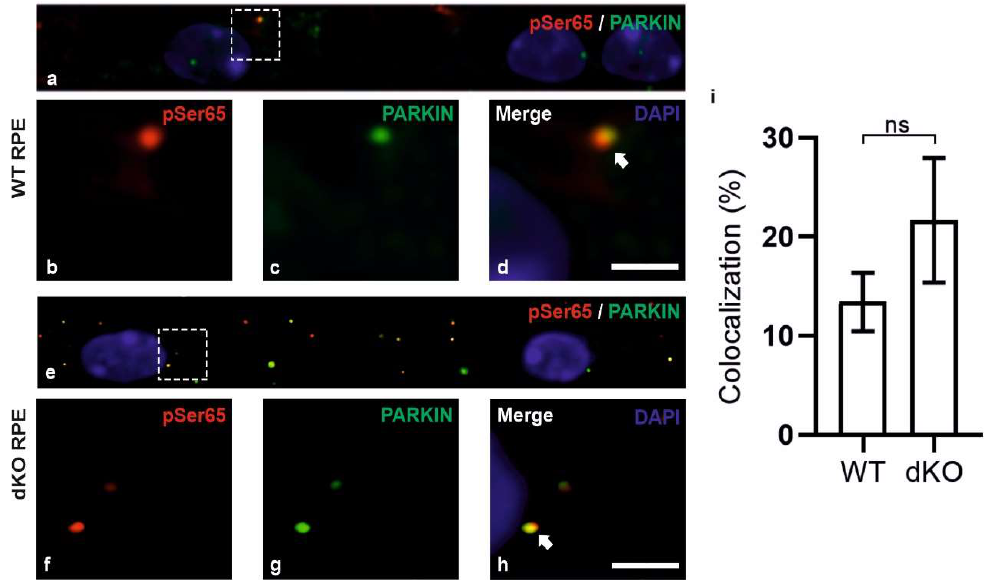
Figure 4. WT and dKO RPE cells ( a , e ) were double-stained for pS65 ( b , f ) and PARKIN ( c , g ) and analyzed by confocal microscopy. In dKO, we observed a ~33% increase in the total puncta with a ~115% increase in colocalization as compared to WT ( d , h and i ). Scale = 5 µm. p = 0.2. ns— Nonsignificant.